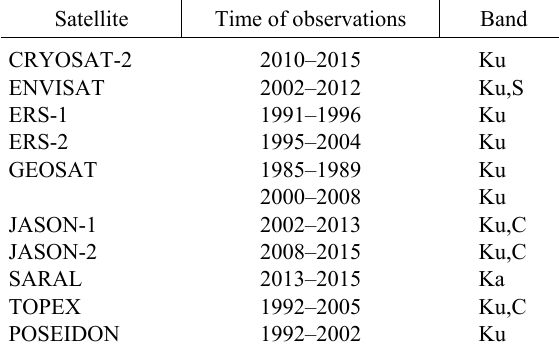
Table 1. Satellite missions that provide altimetry data for the Baltic Sea region. See the descriptions of bands in Vignudelli et al.